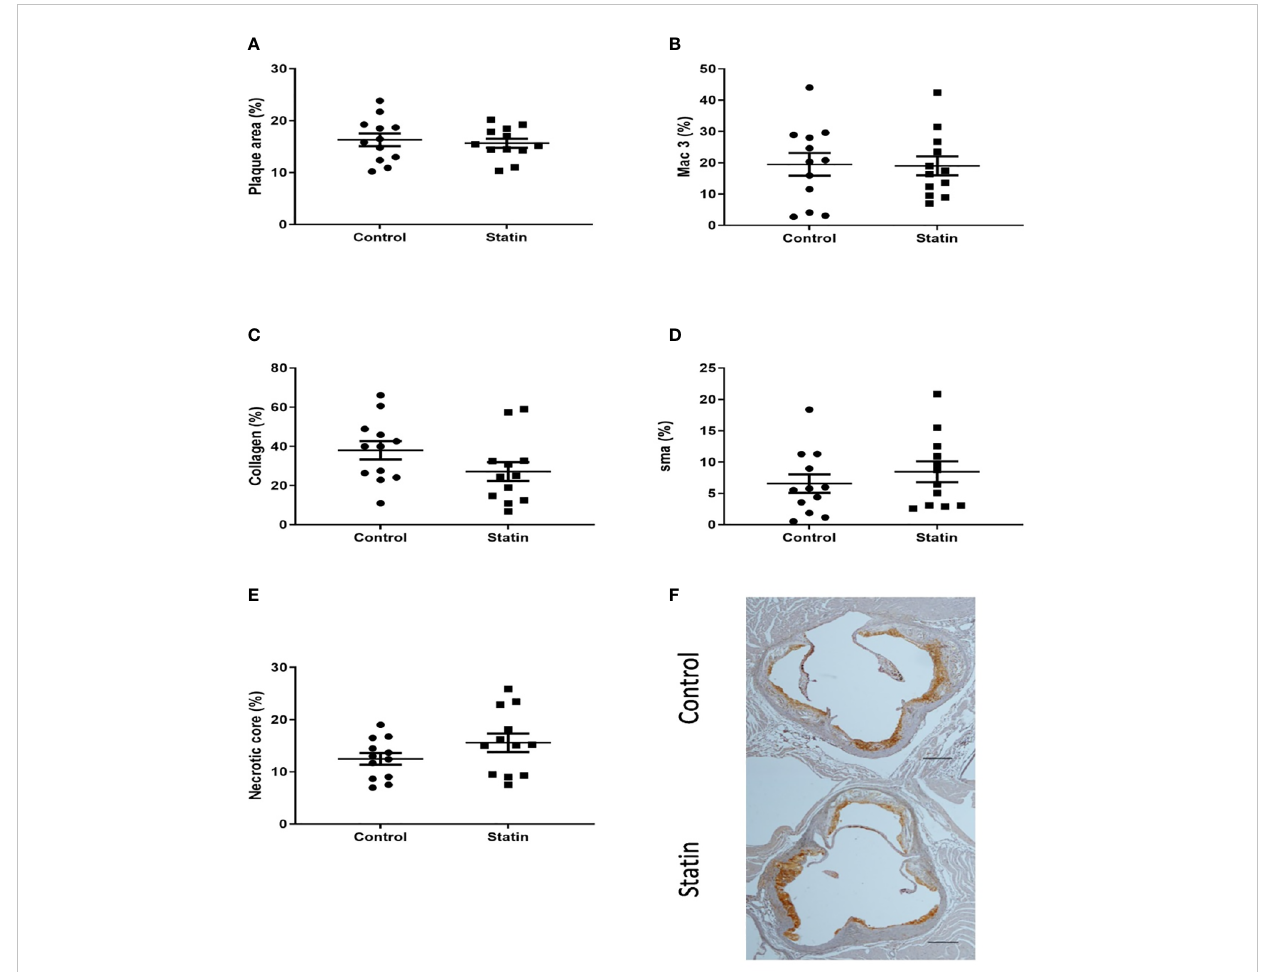
FIGURE 10 Atorvastatin had no effect on aortic sinus plaque size or composition 2 weeks post pneumonia. Quanti fi cation of aortic sinus plaque area (A) , plaque macrophage (B) , collagen (C) , smooth muscle (D) content and necrotic core area (E) (n=12). Representative images (F) of MAC-3 immunostained aortic sinus sections from a S. pneumoniae infected ApoE -/- mouse (n=12) following atorvastatin therapy and an infected control mouse (n=12) given methylcellulose only. Scale bars represent 400